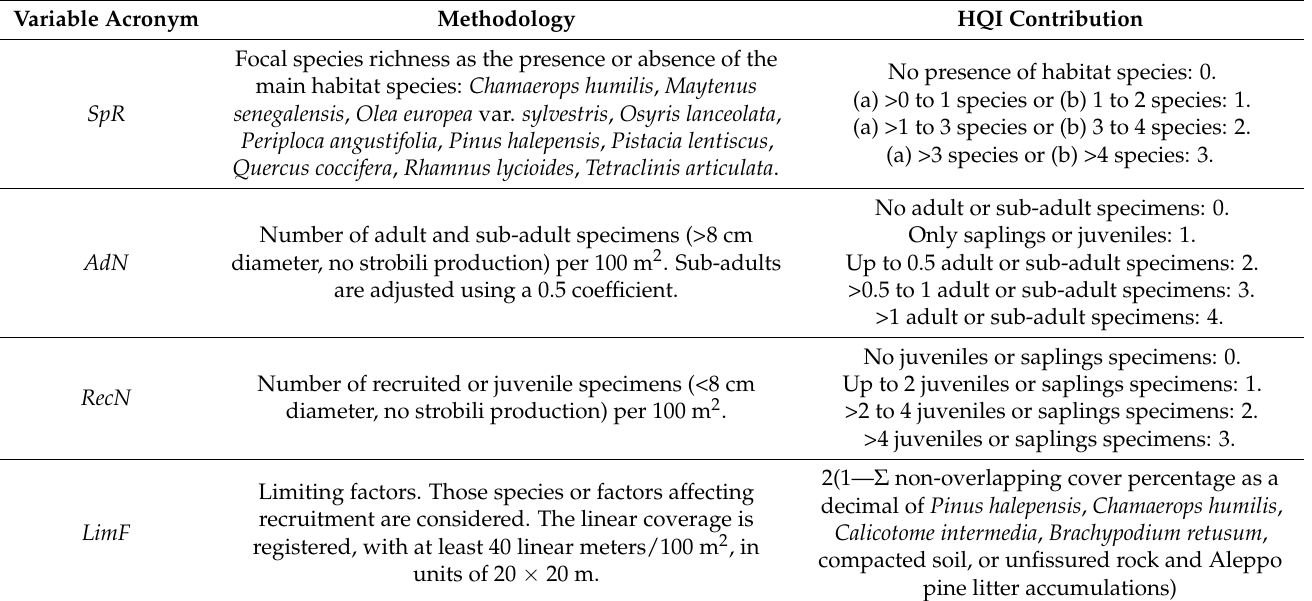
Table 2. Variables used to calculate the habitat quality index (HQI) and applied methodologies. Contribution to the quality index corresponds to either (a) 100 m 2 or (b) 400 m 2 of survey plot size. SpR : focal species richness, AdN : No. of adults and sub-adults, RecN : No. of saplings and